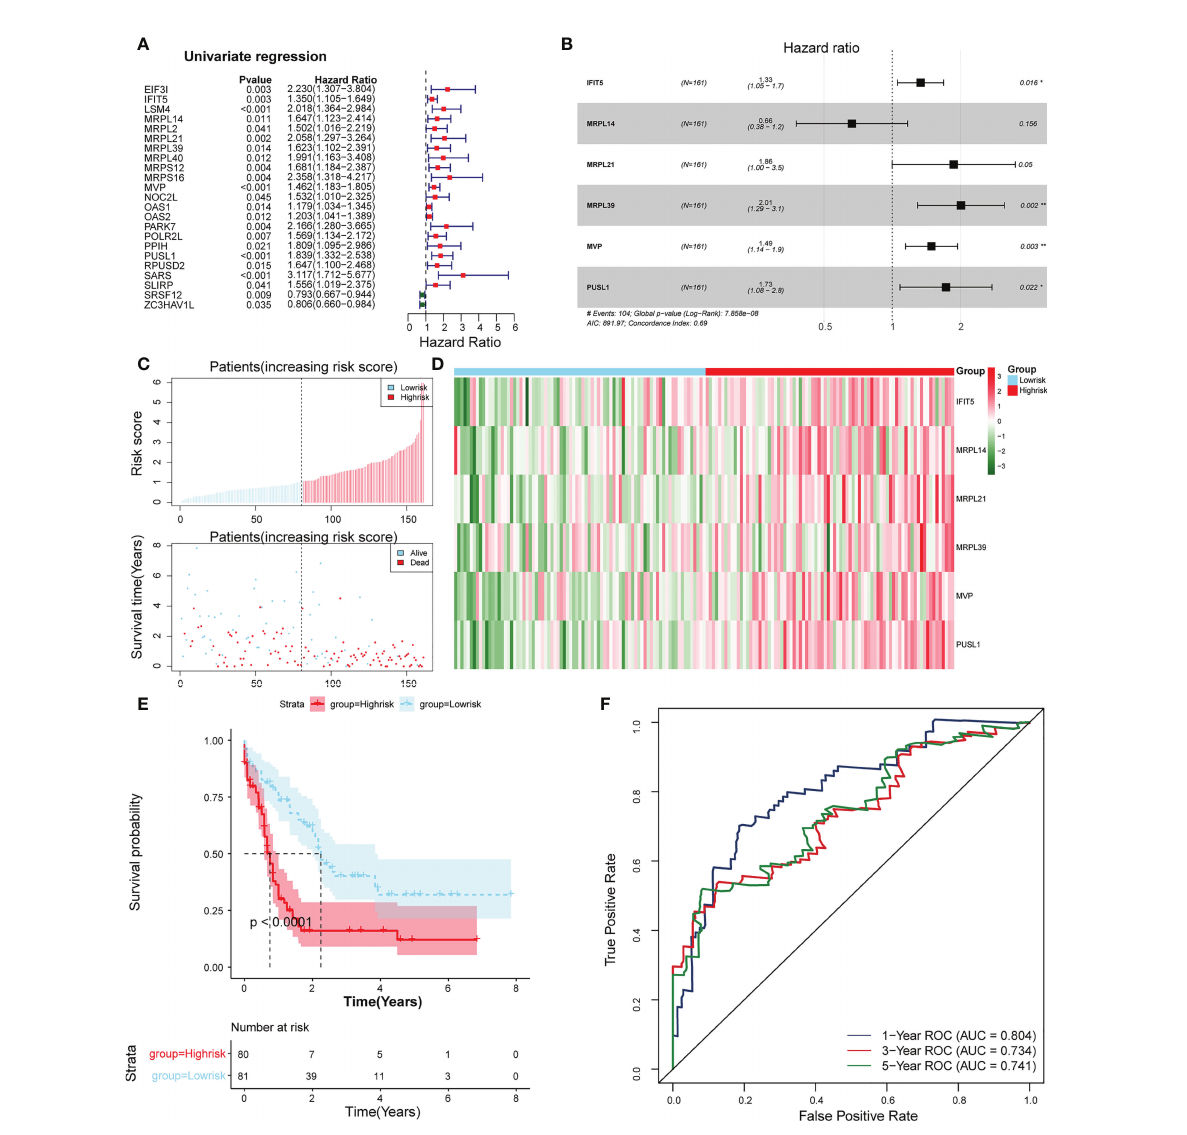
FIGURE 3 Establishment of a risk model based on 6 biomarkers. (A) Univariate Cox analysis of PRBP-DEGs which were selected by PPI network. (B) Multivariate Cox analysis to screen biomarkers. * represents p < 0.05, ** represents p < 0.01. (C) Distributions of risk scores and survival states between high- and low-risk groups in the training set. (D) Heatmap of 6 biomarkers in high- and low-risk groups. (E) The Kaplan-Meier survival curve for the high-and low-risk groups in the training set. (F) ROC curves at 1-, 3-, and 5 years in the training set.